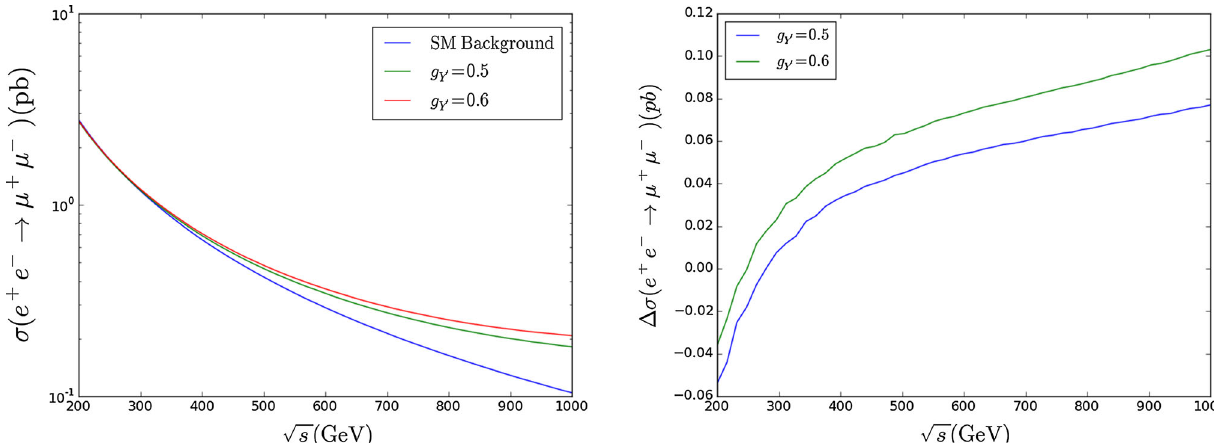
Fig. 4 Modified production rate σ( e + e − → μ + μ − ) , which is relevant in searches for Z (cid:3) at